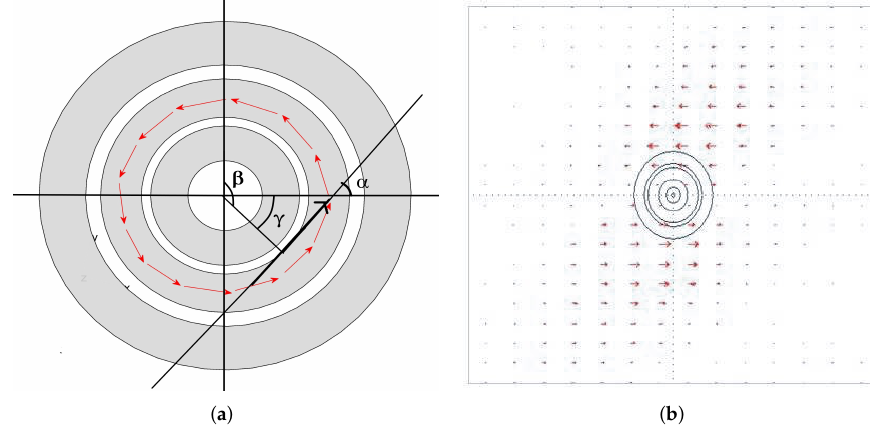
Figure 2. COMSOL ® Multiphysics: ( a ) current density in the exciting coil and ( b ) EC distribution in the